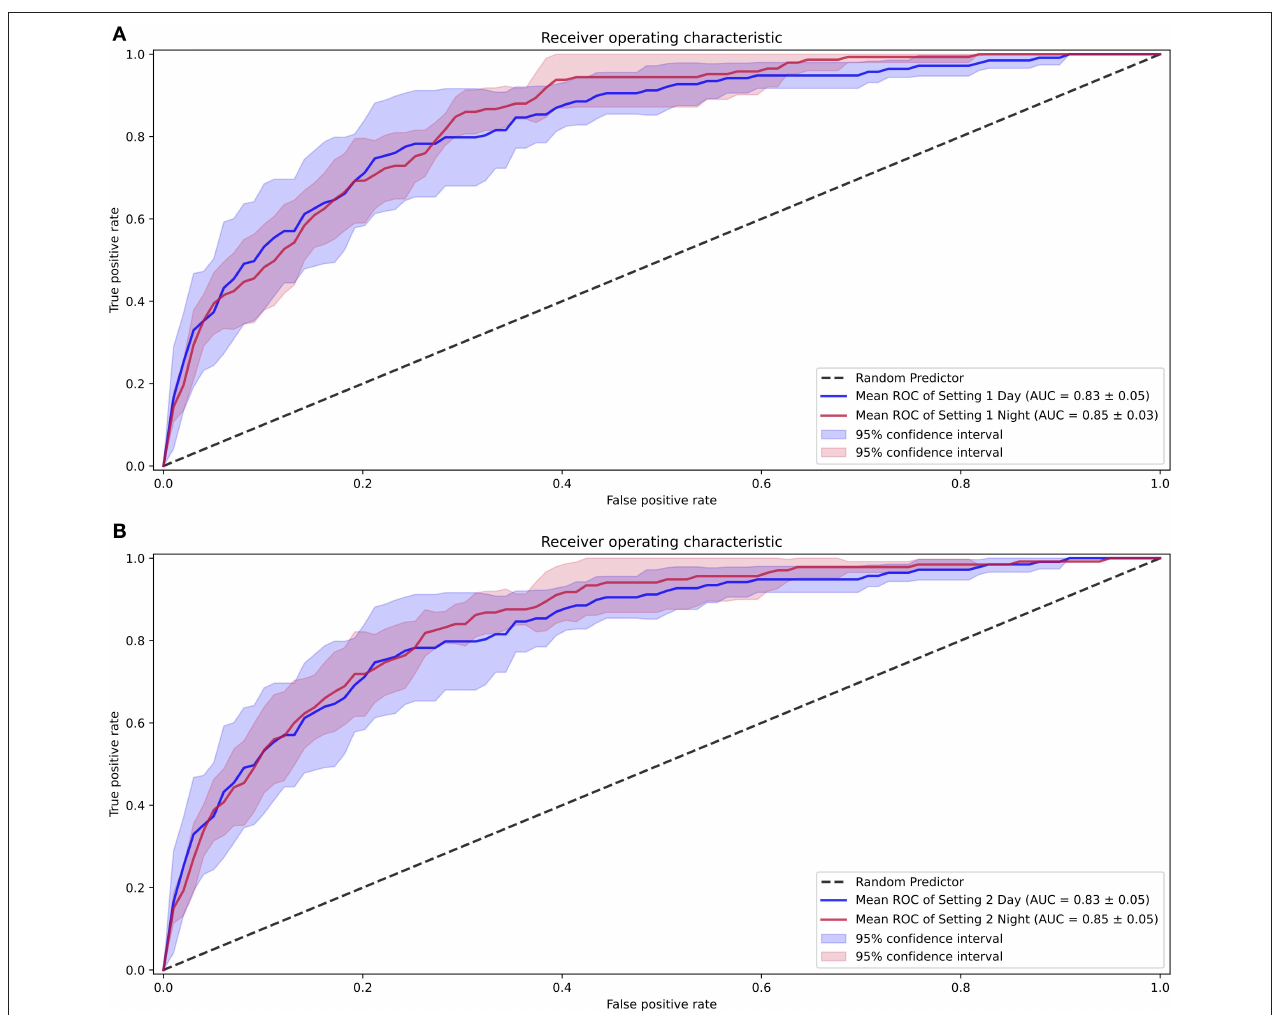
FIGURE 6 | Receiver operating characteristic curves for the differences seen with diurnal periods. (A) Performance with setting 1. (B) Performance with setting 2.